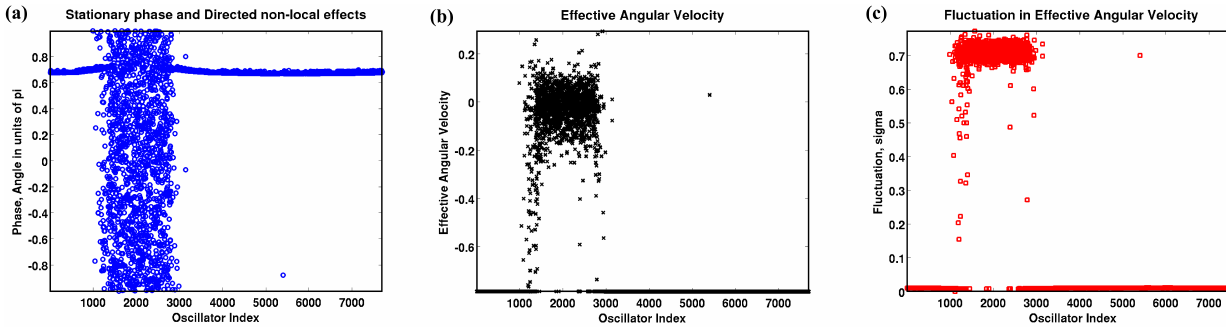
Figure 7. Three attributes of a chimera state of the 7697 oscillators for a 1024 × 1024 gridded map with recurrences using κ = 0.10. (a) Sta- tionary phase angle. (b) Effective angular velocity. (c) Fluctuations in instantaneous angular